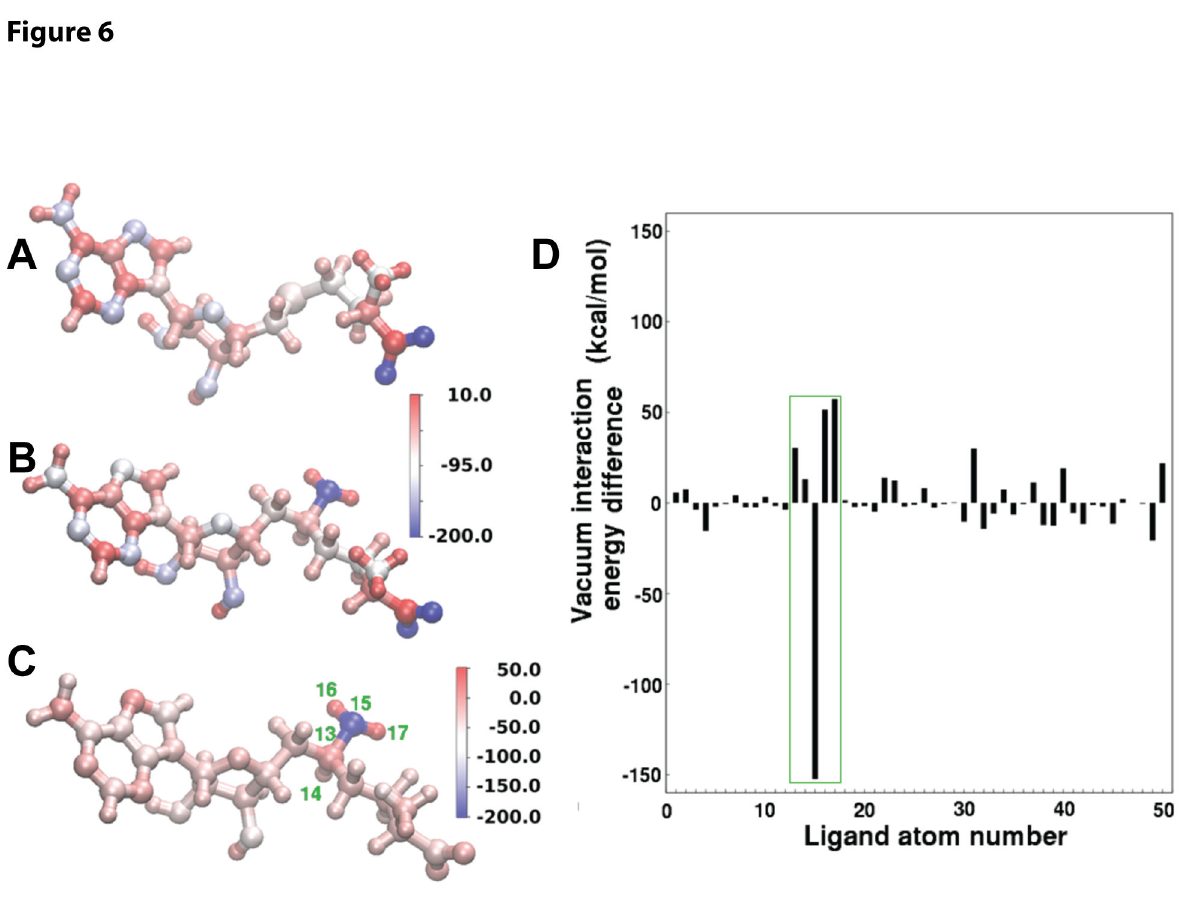
Figure 6. Atomic decomposition of the vacuum interaction energy between the AdoHcy and SIN ligands and the WNV MTase. Color coded projection onto the individual ligand atoms of the interaction energy between AdoHcy (panel A ), SIN (panel B ), and the difference (SIN-AdoHcy projected on SIN, panel C ), and the WNV MTase. Panel D shows the numerical value of the interaction energy difference between the two ligands with the chemically different atoms bounded by a green box. The chemical difference is localized to atoms 13-17: atom 13 is a sulfur in AdoHcy, while atoms 13-17 are CHNH2 in SIN. The atoms numbers are indicated by green labels in panel C. All values are in